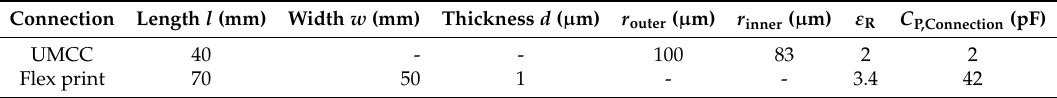
Table 3. Shield of connection to circuit board